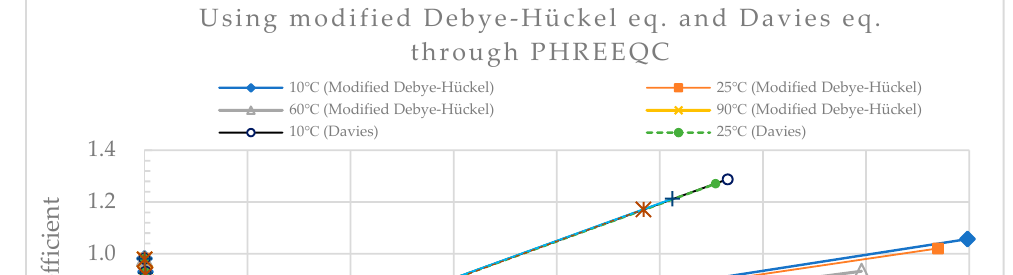
Figure 14. Dependence of the activity coefficient of Na + on the ionic strength for different activity coefficient equations through EQ3/6.